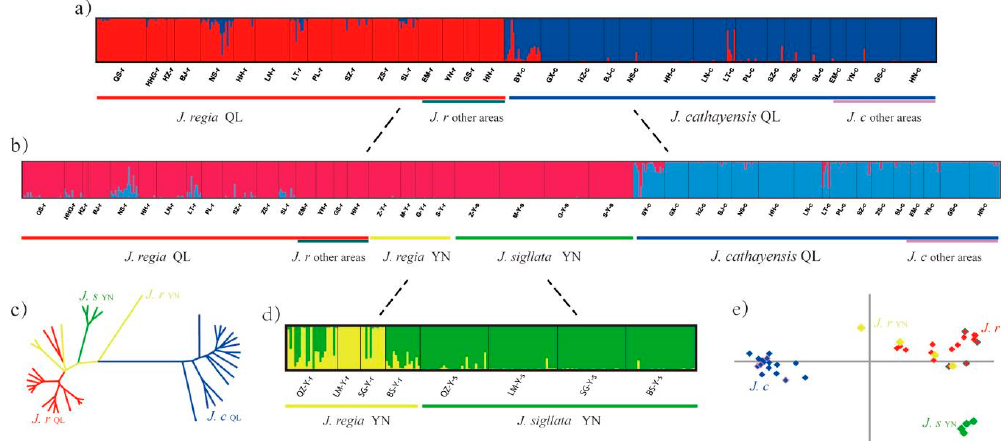
Figure 4. Genetic clustering of all individuals of J. regia , J. cathayensis and J. sigillata. ( a , d ) Population cluster analysis of the sympatric J. regia versus J. cathayensis populations and J. regia versus J. sigillata populations using STRUCTURE ( K = 2) based on the EST-SSR datasets. ( b ) Population cluster analysis of three walnut species using STRUCTURE ( K = 2) based on the EST-SSR datasets. ( c ) The UPGMA tree